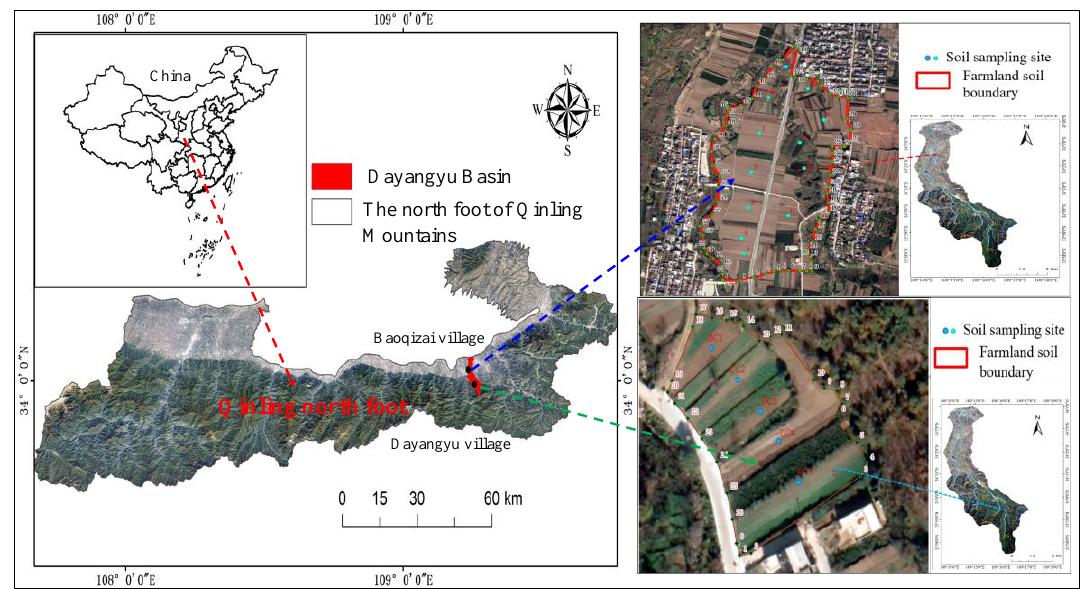
Figure 1. Geographical location diagram of the study area.